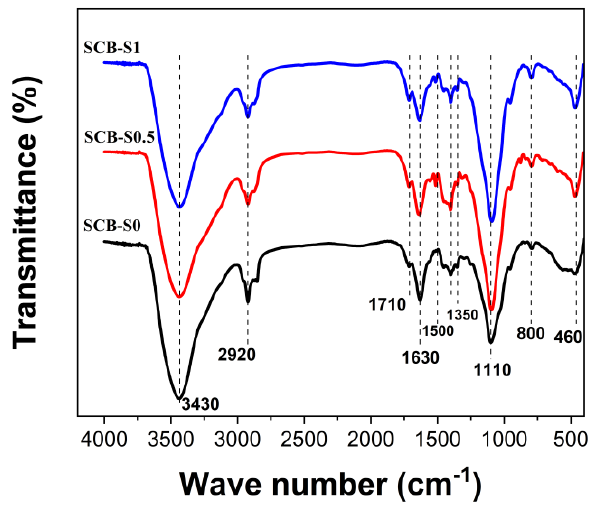
Figure 2. FT-IR spectra of the hybrid gels, TEOS and FA.